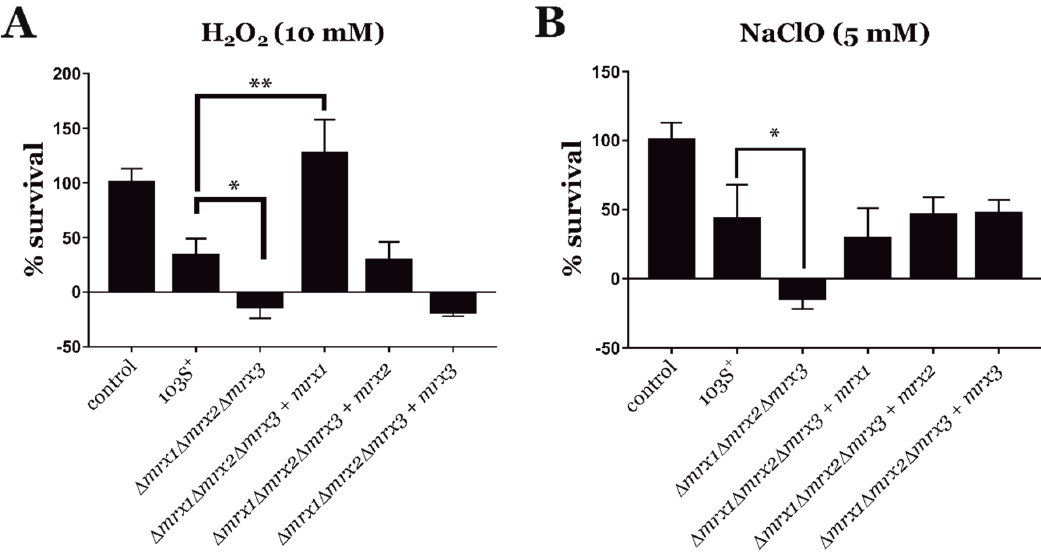
Figure 2. In vitro viability of R. equi strains after 3 h in trypticase soy broth (TSB) supplemented with either 10 mM H 2 O 2 ( A ) or 5 mM sodium hypochlorite NaClO ( B ). Control: R. equi 103S + cultured on plain TSB. Bacterial viability was measured by quantifying the number of CFUs of each strain at 3 h, and data were normalized by the percentage of R. equi 103S + CFUs recovered from plain TSB. Data are expressed as means ± SD of three independent experiments. One-way ANOVA and post hoc Tukey´s multiple comparison tests were performed to assess for statistical significance across conditions. p -value < 0.05 (*) or p -value < 0.01 (**). Antioxidants 2019 , 8 , x FOR PEER REVIEW